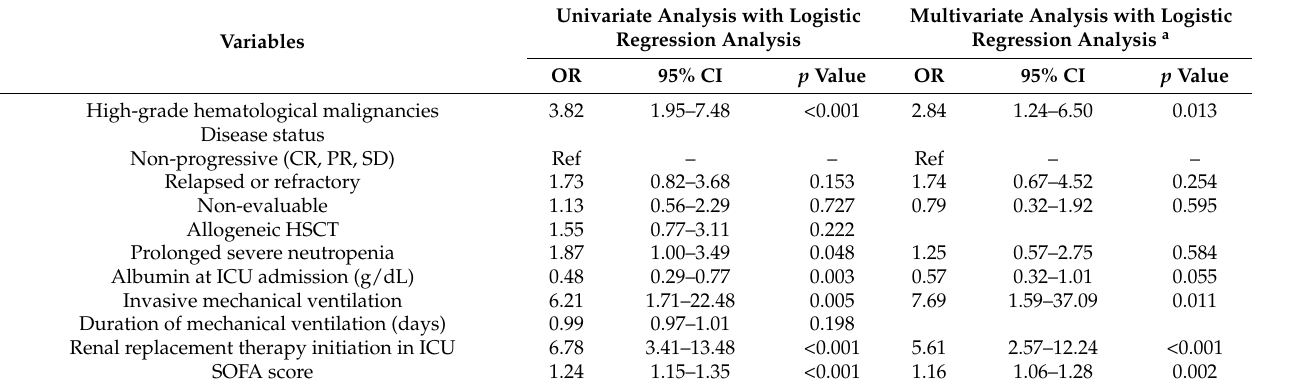
Table 3. Univariate analysis and multivariate logistic regression analysis of the prognostic variables for ICU